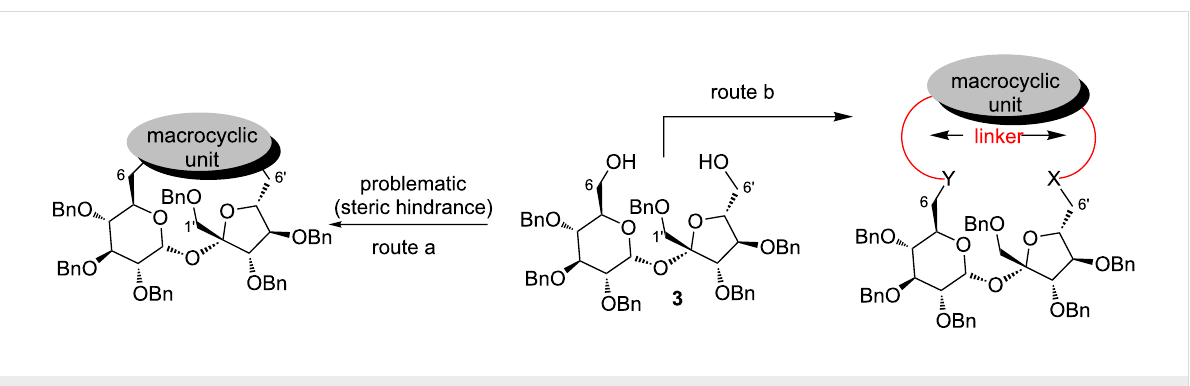
Figure 2: Strategy to sucrose cryptands with additional macrocyclic